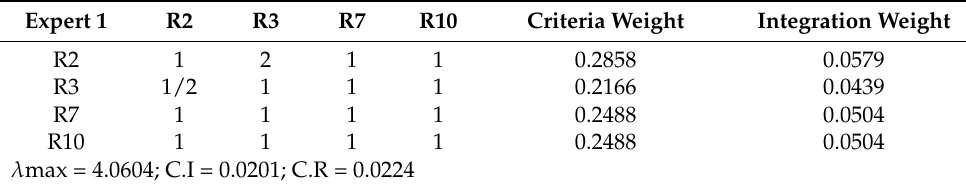
Table 6. The consistency and weight value of human resource (RA1) factors. Expert